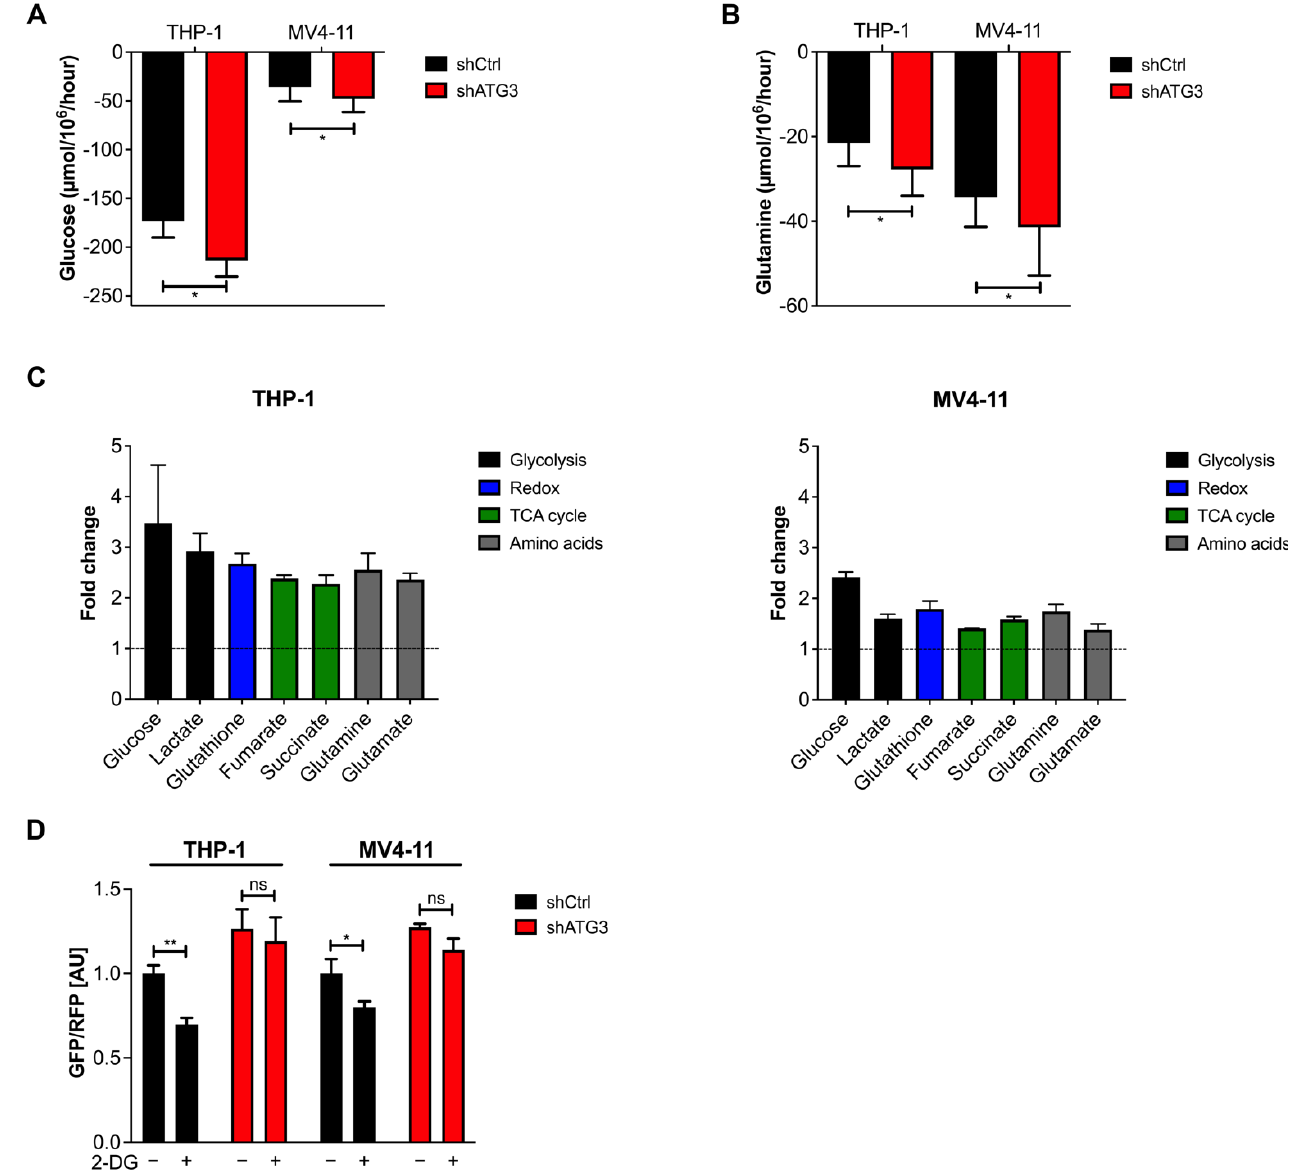
Figure 4. AML cells rewire their central carbon metabolism upon loss of ATG3. ( A ) Glucose and ( B ) glutamine consumption fluxes are shown. Control or shATG3 cells were incubated for 72 h, and medium was collected afterwards. Glucose and glutamine fluxes were calculated by measuring extracellular glucose and glutamine concentrations by spectrophotometric assays and normalizing it to the cell number. ( C ) Intracellular concentrations of central metabolites depicted as fold change (normalized to control) measured by NMR. ( D ) Autophagy flux was measured with the GFP-LC3B-RFP reporter in THP-1 and MV4-11 cells and normalized to the shCtrl untreated condition. The 1 mM 2-DG treatment was performed for 24 h. Student’s t test was performed in ( A , B , D ). Error bars represent SEM. ns, not significant, * p < 0.05, ** p < 0.01.